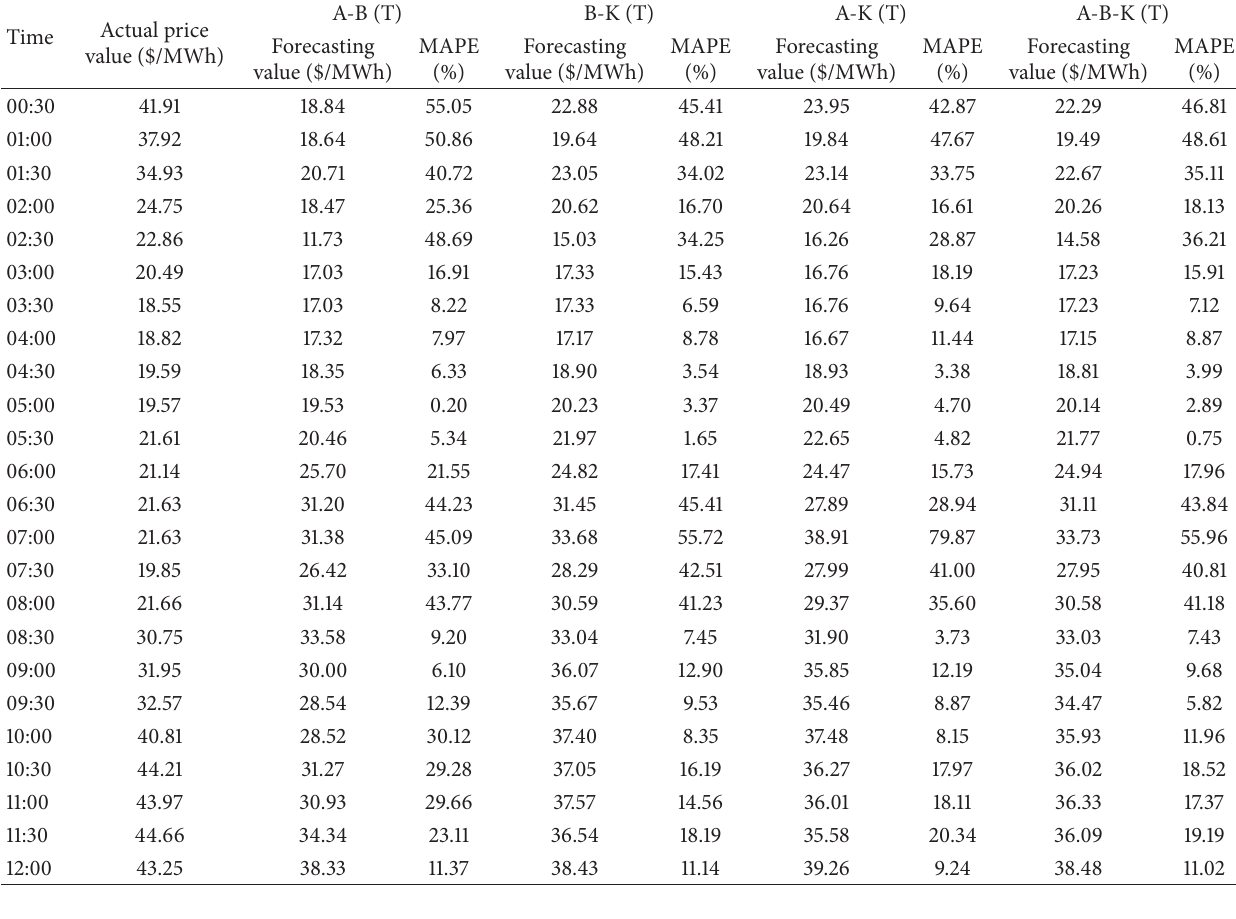
Table 5: Traditional combination models forecasting results.